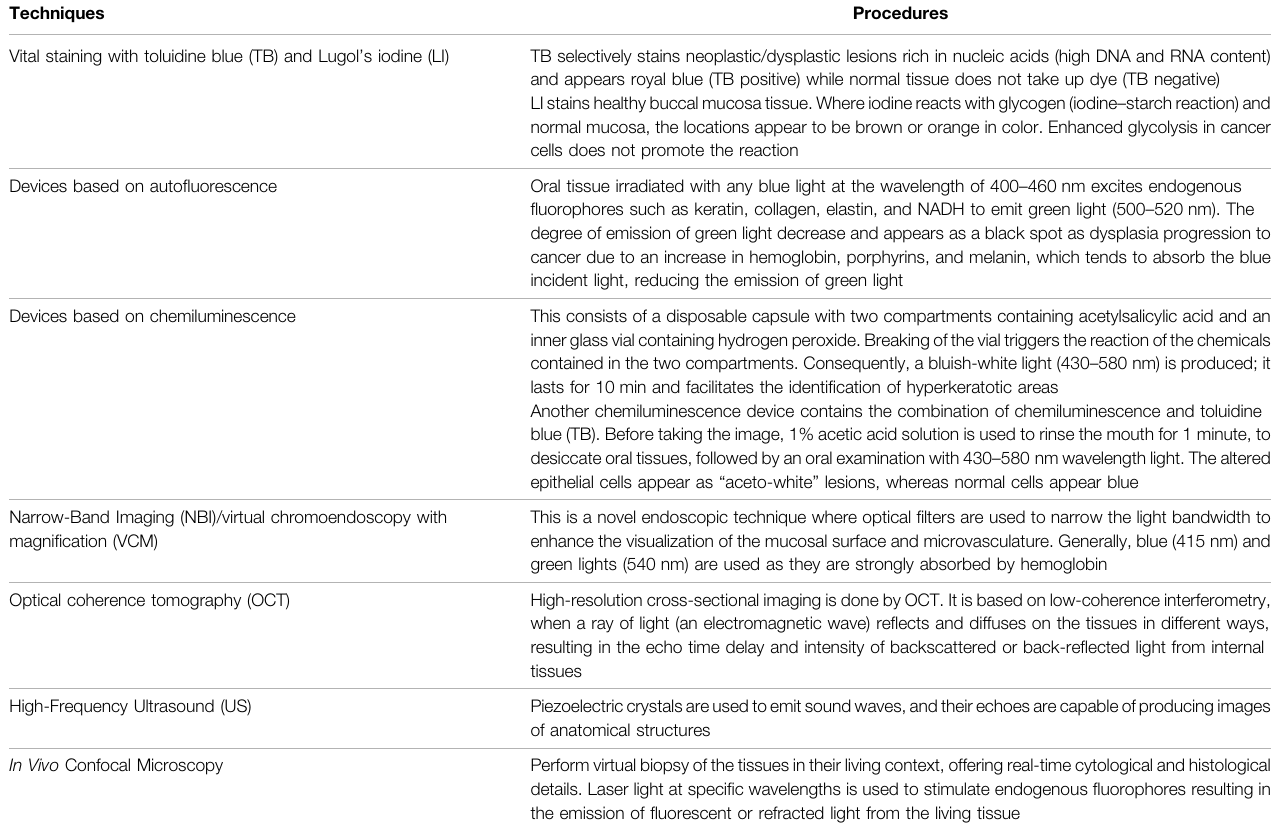
TABLE 2 | Non-invasive OPMDs screening technique. Techniques